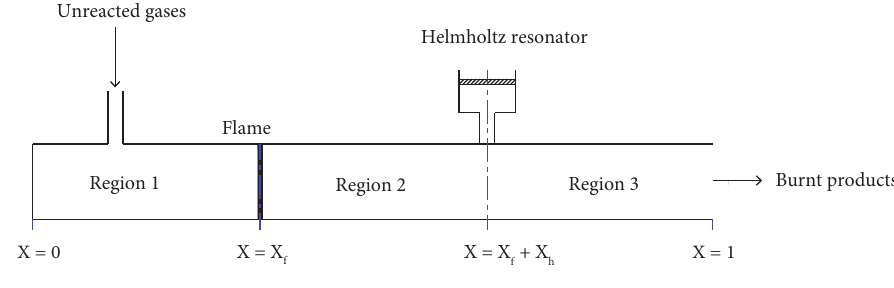
Figure 1. Schematic of open loop trim adjustment active control using tunable Helmholtz